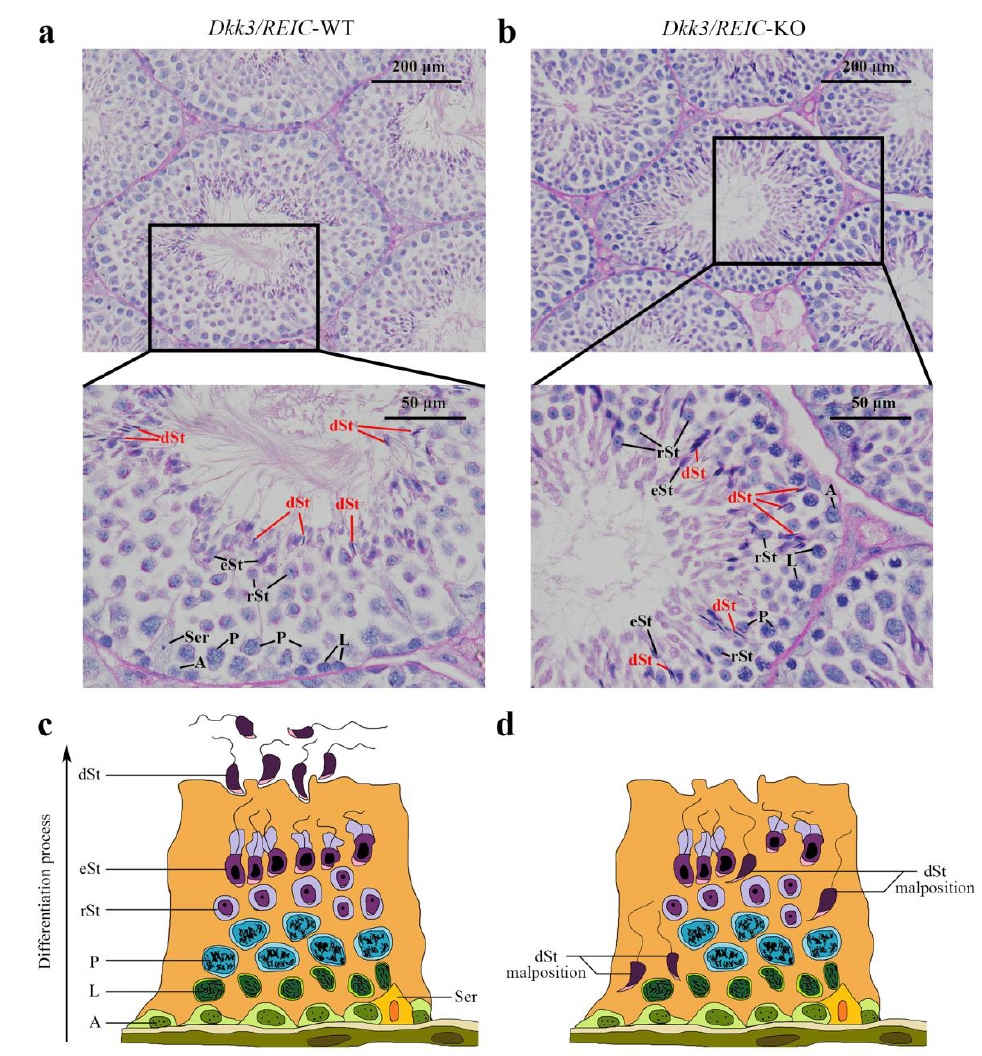
Figure 1. PAS staining of the testicular sections. ( a ) In the Dkk3/REIC -WT testicular section (stage VIII–IX of spermatogenesis), the distribution of germ cells was well arranged, and the tadpole-like differentiated sperm were uniformly located around the seminiferous tubule lumen waiting to be released. ( b ) In the Dkk3/REIC -KO testicular section (stage VIII – IX of spermatogenesis), however, the germ cell distribution was much disordered, few mature spermatids were in or surrounding the central lumen, while the differentiated sperm (marked by in red) irregularly wandered adjacent to the basement membrane. ( c ) The schematic drawing of typical spermatogenesis in the Dkk3/REIC -WT seminiferous epithelium. ( d ) The schematic drawing of pathological spermatogenesis in the Dkk3/REIC -KO seminiferous epithelium. Abbreviation: A = spermatogonia, Ser = sertoli cell, L = spermatocytes in leptotene phase, P = spermatocytes in pachytene phase, rSt = round spermatids, eSt = elongated spermatids and dSt = differentiated spermatids.